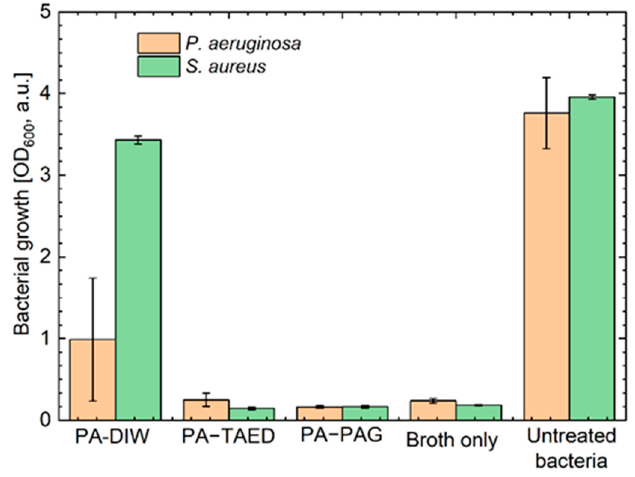
Figure 12. Growth of P. aeruginosa and S. aureus measured after treatment with PA-DIW, PA-TAED and PA-PAG. Sterile broth and untreated bacterial suspensions were used as negative and positive controls of bacterial growth, respectively.